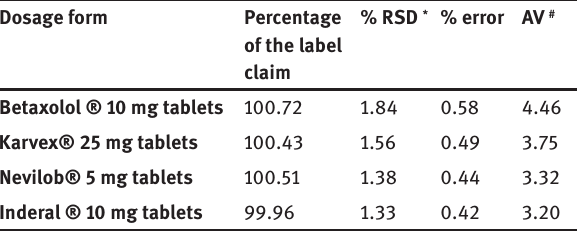
Table 6: Results of content uniformity testing of the studied β- blockers tablets using the proposed